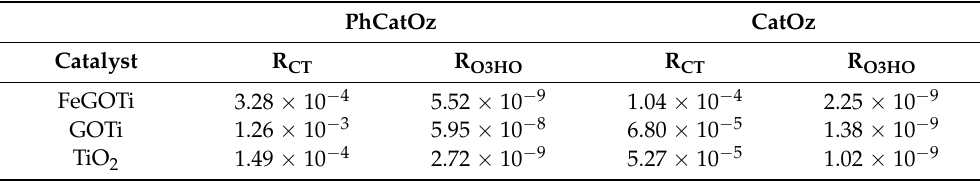
Table 4. Values of R CT and R O3HO for PhCatOz and CatOz processes with different catalysts. Condi- tions as in Table